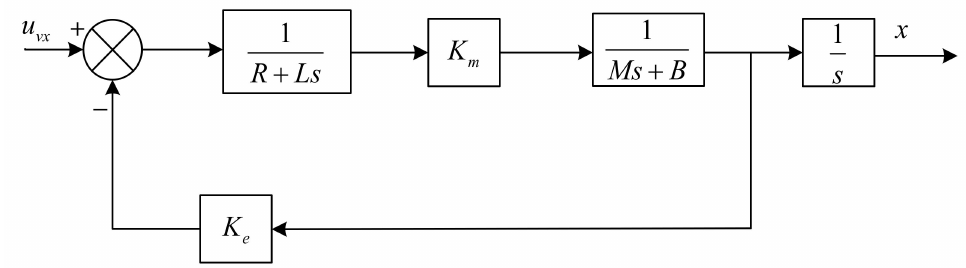
Figure 5. Simulation model of linear motor.